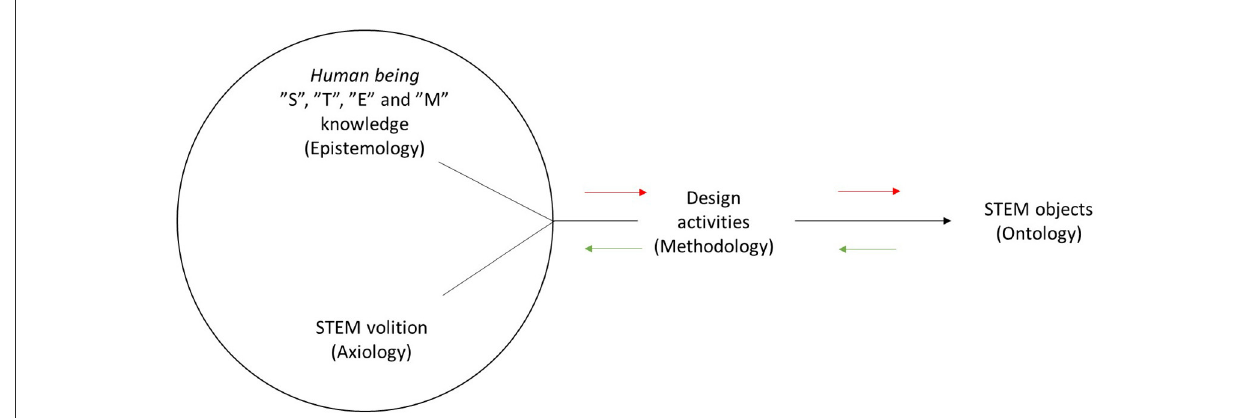
FIGURE2 A reinterpretation of Mitcham’s (1994) philosophical framework for STEM